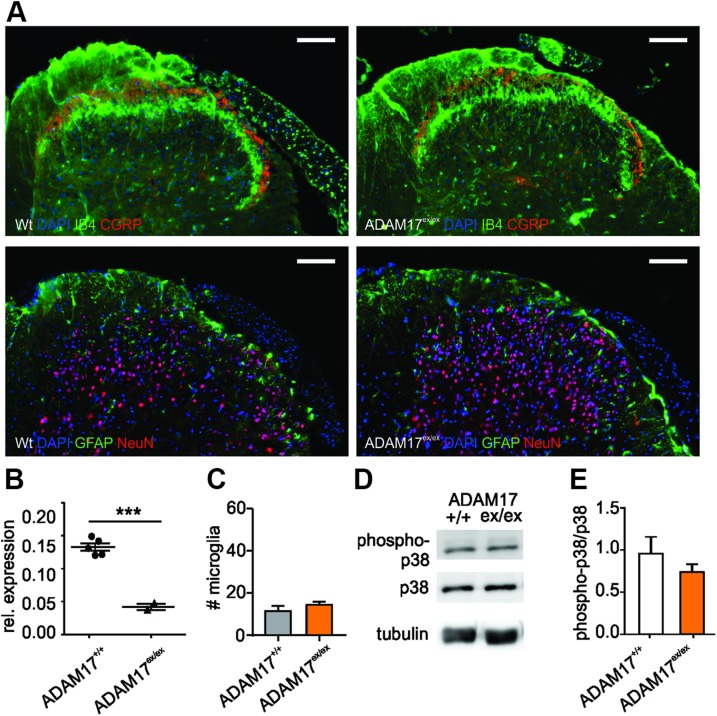
ADAM17 down-regulation does not affect spinal dorsal horn architecture or microglia activity. A) Representative staining of the dorsal horn of the spinal cord from ADAM17+/+ and ADAM17ex/ex mice. The expression and morphology of nociceptive IB4-positive and CGRP-positive neurons was similar to control animals, as was the distribution of neurons (NeuN-positive) and astrocytes [glial fibrillary acidic protein (GFAP)-positive]. Scale bars, 100 µm. B) ADAM17 mRNA expression was down-regulated in spinal cord from ADAM17ex/ex mice (n = 5; unpaired Student’s t test with Welch’s correction, P < 0.001). C) The number of activated microglia was unchanged in the dorsal horn of the spinal cord of ADAM17ex/ex mice in comparison with controls (14.44 ± 1.56 vs. 11.44 ± 2.58; n = 3; unpaired Student’s t test, P = 0.3762). D) Representative Western blot for the phosphorylated levels of p38 in the dorsal horn of the spinal cord of ADAM17ex/ex and control mice. E) Protein levels of phosphorylated p38 (phospho-p38) did not differ between genotypes (0.96 ± 0.2 for ADAM17+/+
vs. 0.74 ± 0.09 for ADAM17ex/ex; n = 3; unpaired Student’s t test, P = 0.3777). Results are shown as means ± sem. ***P < 0.001.